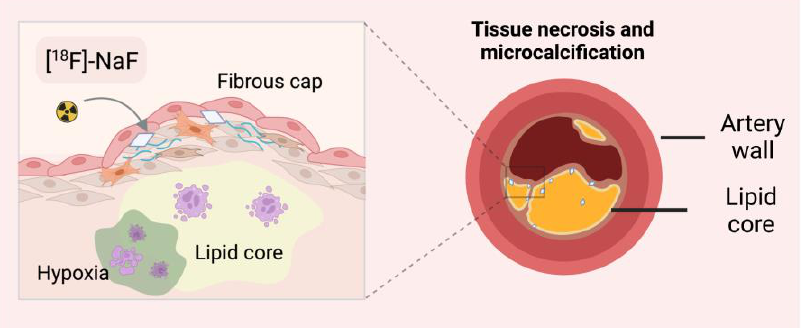
Figure 4. Detection of microcalcifications with [ 18 F]-sodium fluoride ([ 18 F]-NaF). CT – computed